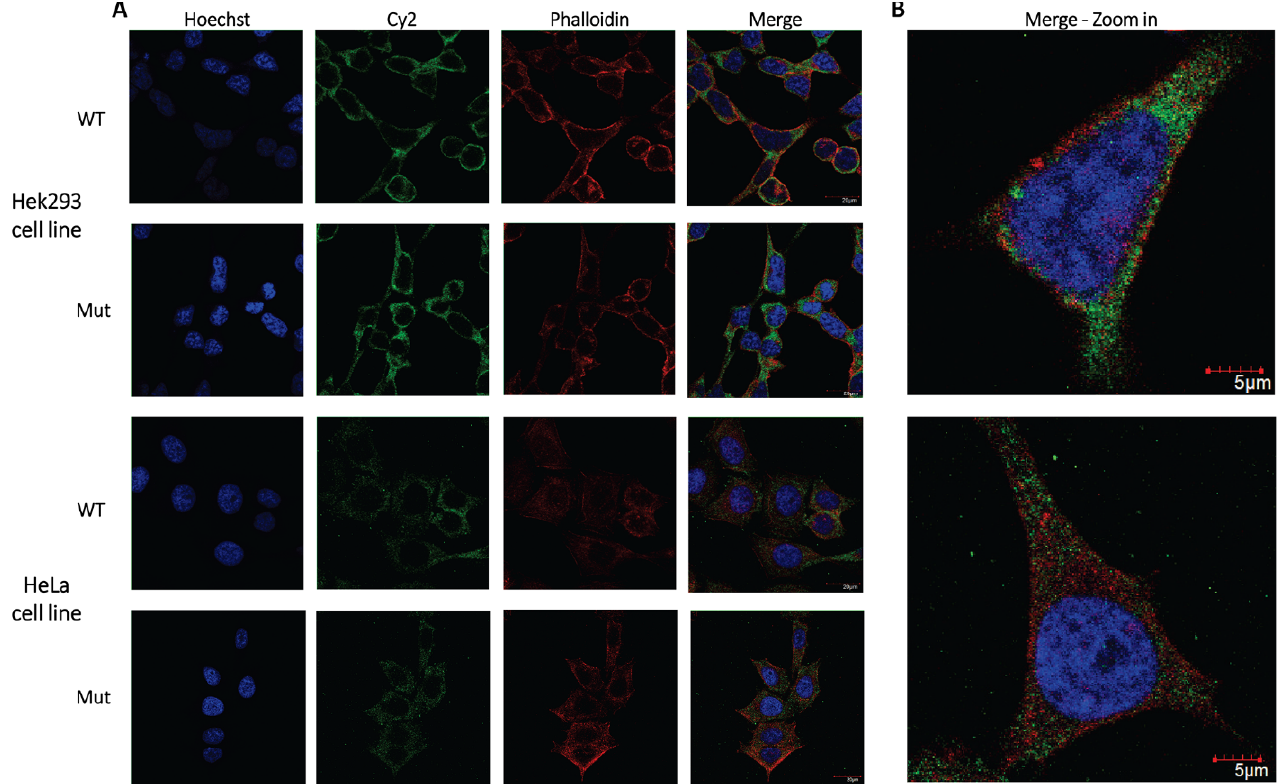
Figure 2. Subcellular localization of the normal and variant PHACTR2 proteins and co ‐ localization of PHACTR2 and actin. ( A ) Hek293 and HeLa cell lines were infected with Lentiviruses containing the normal (WT) or His511 (Mut) PHACTR2 coding sequence fused to myc tags. The subcellular localization of the PHACTR2 construct was visualized by confocal microscopy. PHACTR2 protein is marked by Cy2 in green, F ‐ actin by phalloidin ‐ Alexa Fluor 546 in red, and nuclear staining by Hoechst 33342 in blue. ( B ) Merged magnification of WT PHACTR2 staining for each cell line, respectively, demonstrates that PHACTR2 does not co ‐ localize with F ‐ actin.